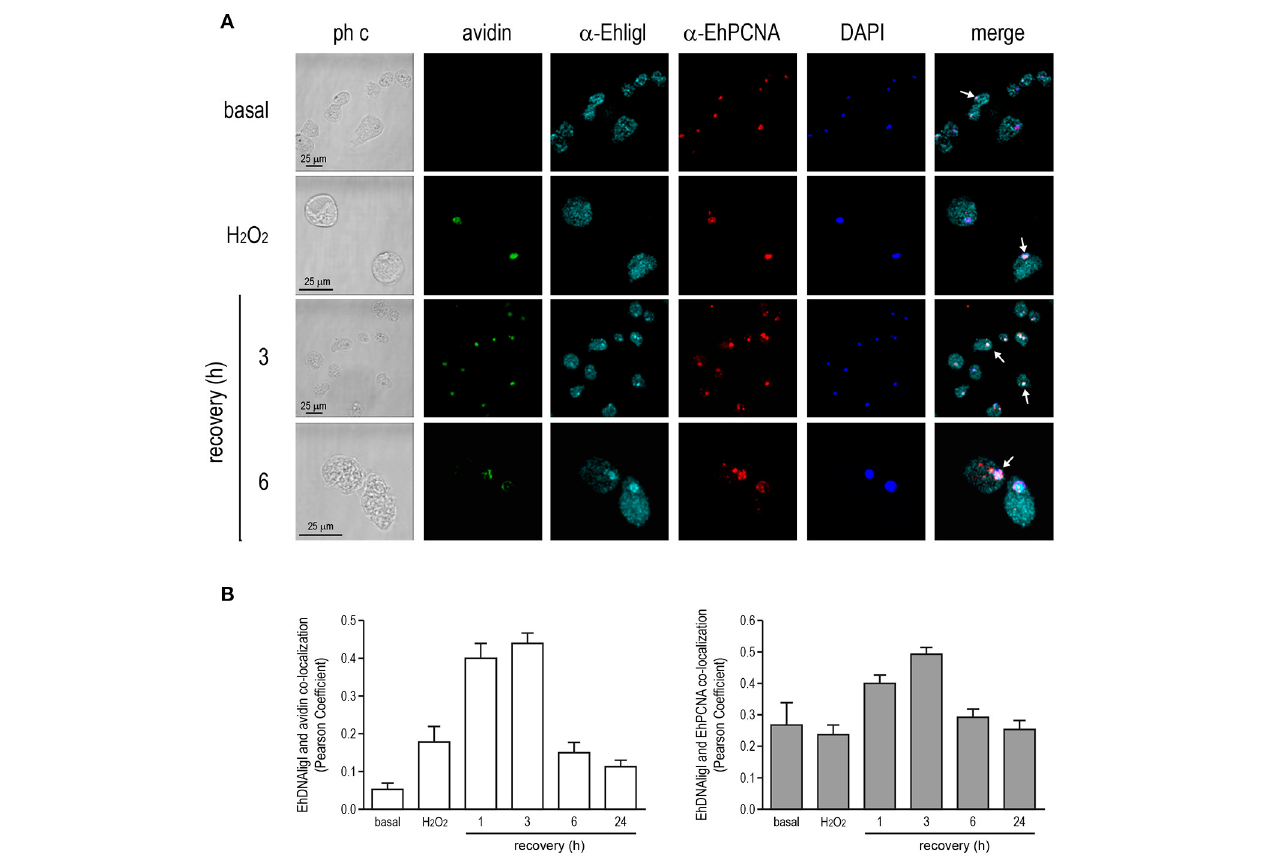
FIGURE 9 | Co-localization of EhDNAligI with EhPCNA after H 2 O 2 treatment. (A) Immunofluorescence assays of trophozoites in basal condition, immediately after H 2 O 2 (2.5mM for 1h) or at 3 and 6h of recovery, using α -EhDNAligI ( α -EhligI) and α -EhPCNA antibodies coupled to Alexa647 (cyan) and Alexa555 (red), respectively. 8-oxoG presence was detected with avidin-FITC (green). Nuclei were counterstained with DAPI (blue). Confocal microscopy images show a xy -section. ph c: Phase-contrast. Arrows: co-localization of EhDNAligI and EhPCNA. (B) Nuclear co-localization of avidin with EhDNAligI and EhDNAligI with EhPCNA was correlated by Pearson